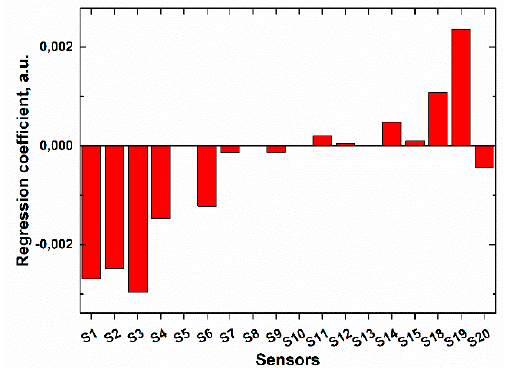
Regression coe ffi cients for di ff erent sensors of the array in the PLS model for Figure 5. Regression coefficients for different sensors of the array in the PLS model for hypochlorite hypochlorite quantification.